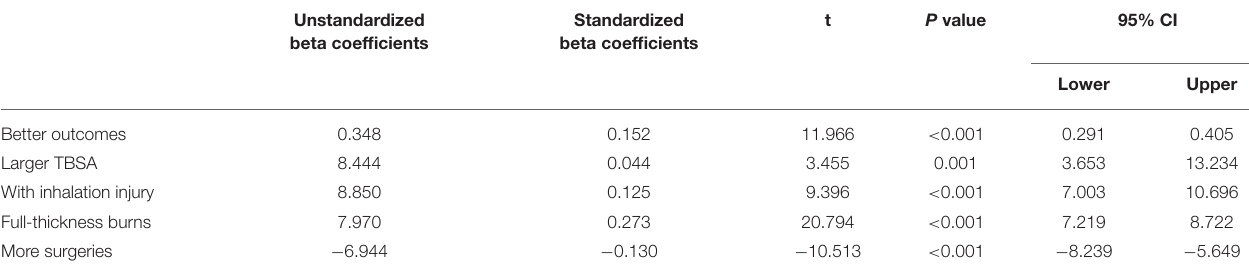
TABLE 5 | Multiple linear regression analysis on related factors of length of stay